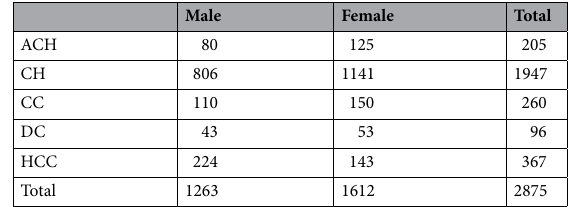
Table 4. Characteristics of patients with hepatitis C. ACH asymptomatic chronic hepatitis, CH chronic hepatitis, CC compensated cirrhosis, DC decompensated cirrhosis, HCC hepatocellular